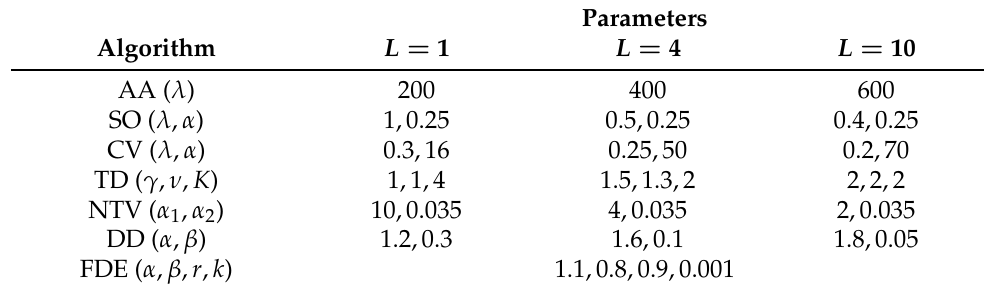
Table 2. Parameter values for numerical simulations on test images in Figure